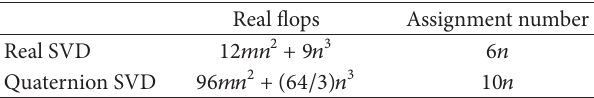
Table 1: Computation amounts and assignment numbers for real SVD and quaternion SVD.